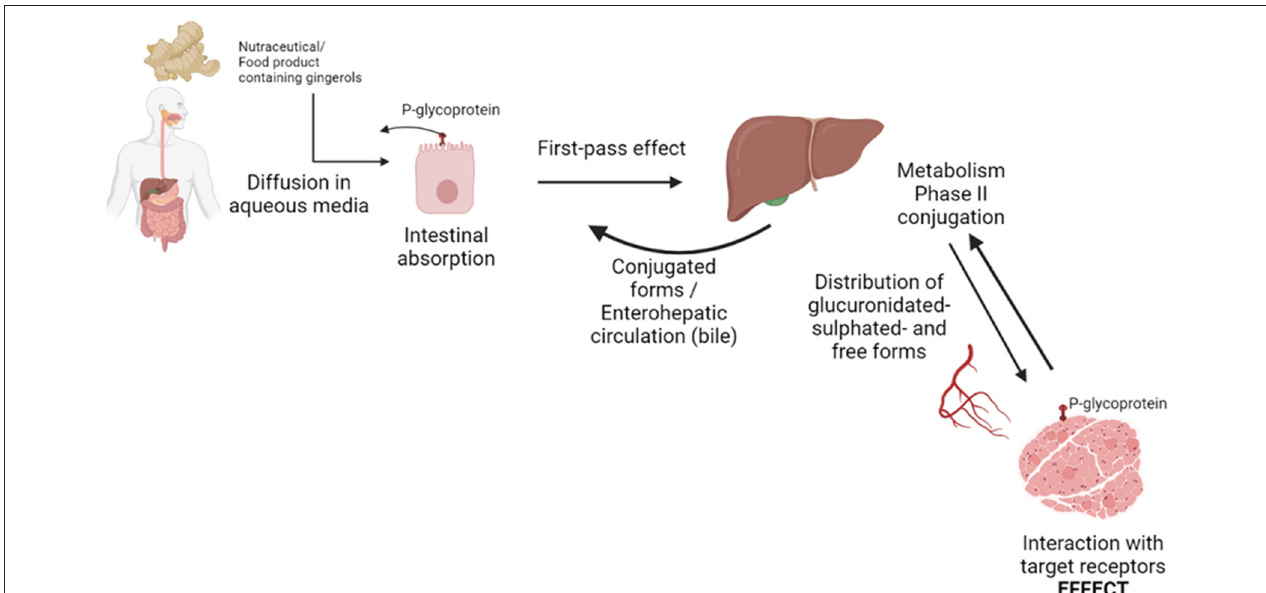
FIGURE 2 | Scheme of bioaccessibility and bioavailability routes of gingerols in the